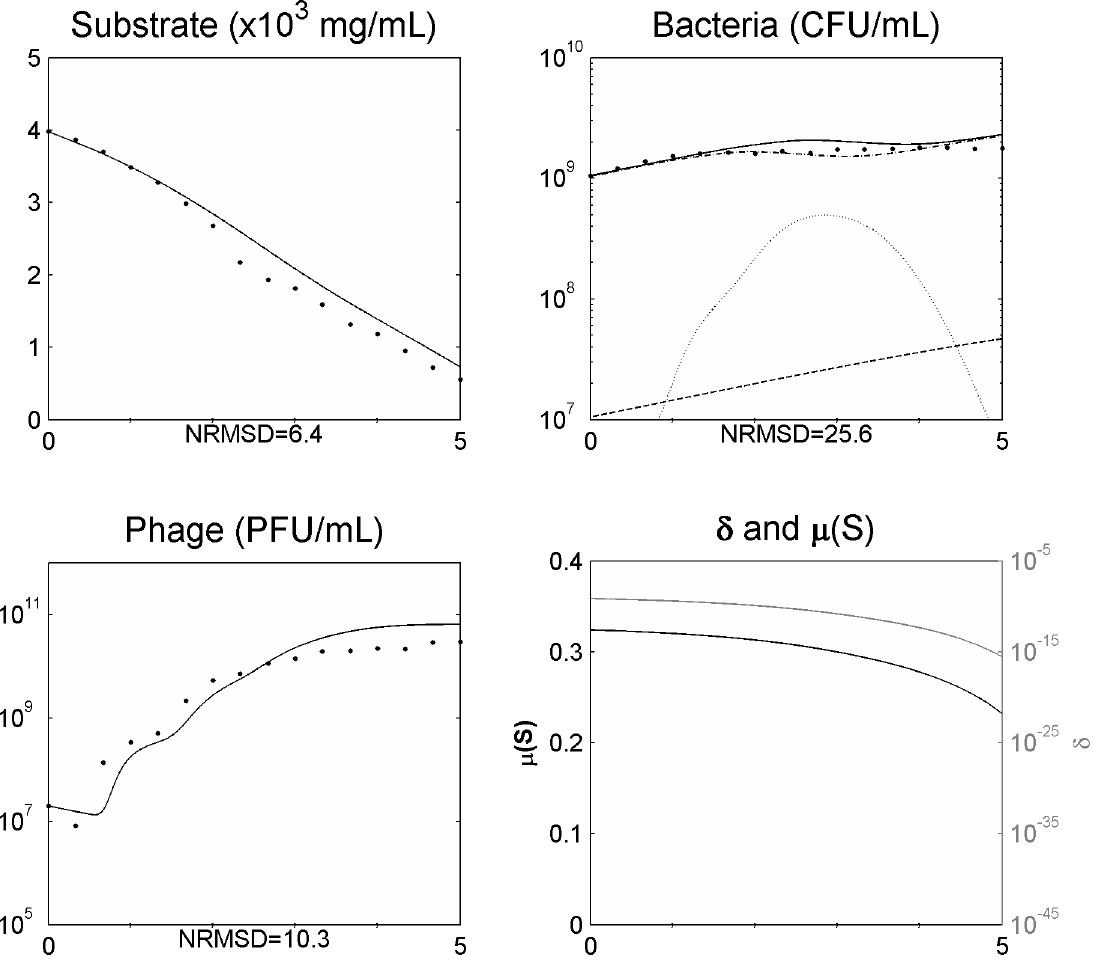
Figure 4. Simulating the phage and bacteria population dynamics using a distribution of values of the latent period and a variation of the adsorption constant ( d ) as a function of the bacterial growth rate ( m ) in a 250 ml Erlenmeyer flask for a MOI=1.8E10 2 2 . Legend: N experimental data; ___ model simulation; - . - model simulation of susceptible uninfected bacteria ( X s ); … model simulation of infected bacteria ( X i ); _ _ model simulation of resistant bacteria ( X r ). The x axis represents time in hours.